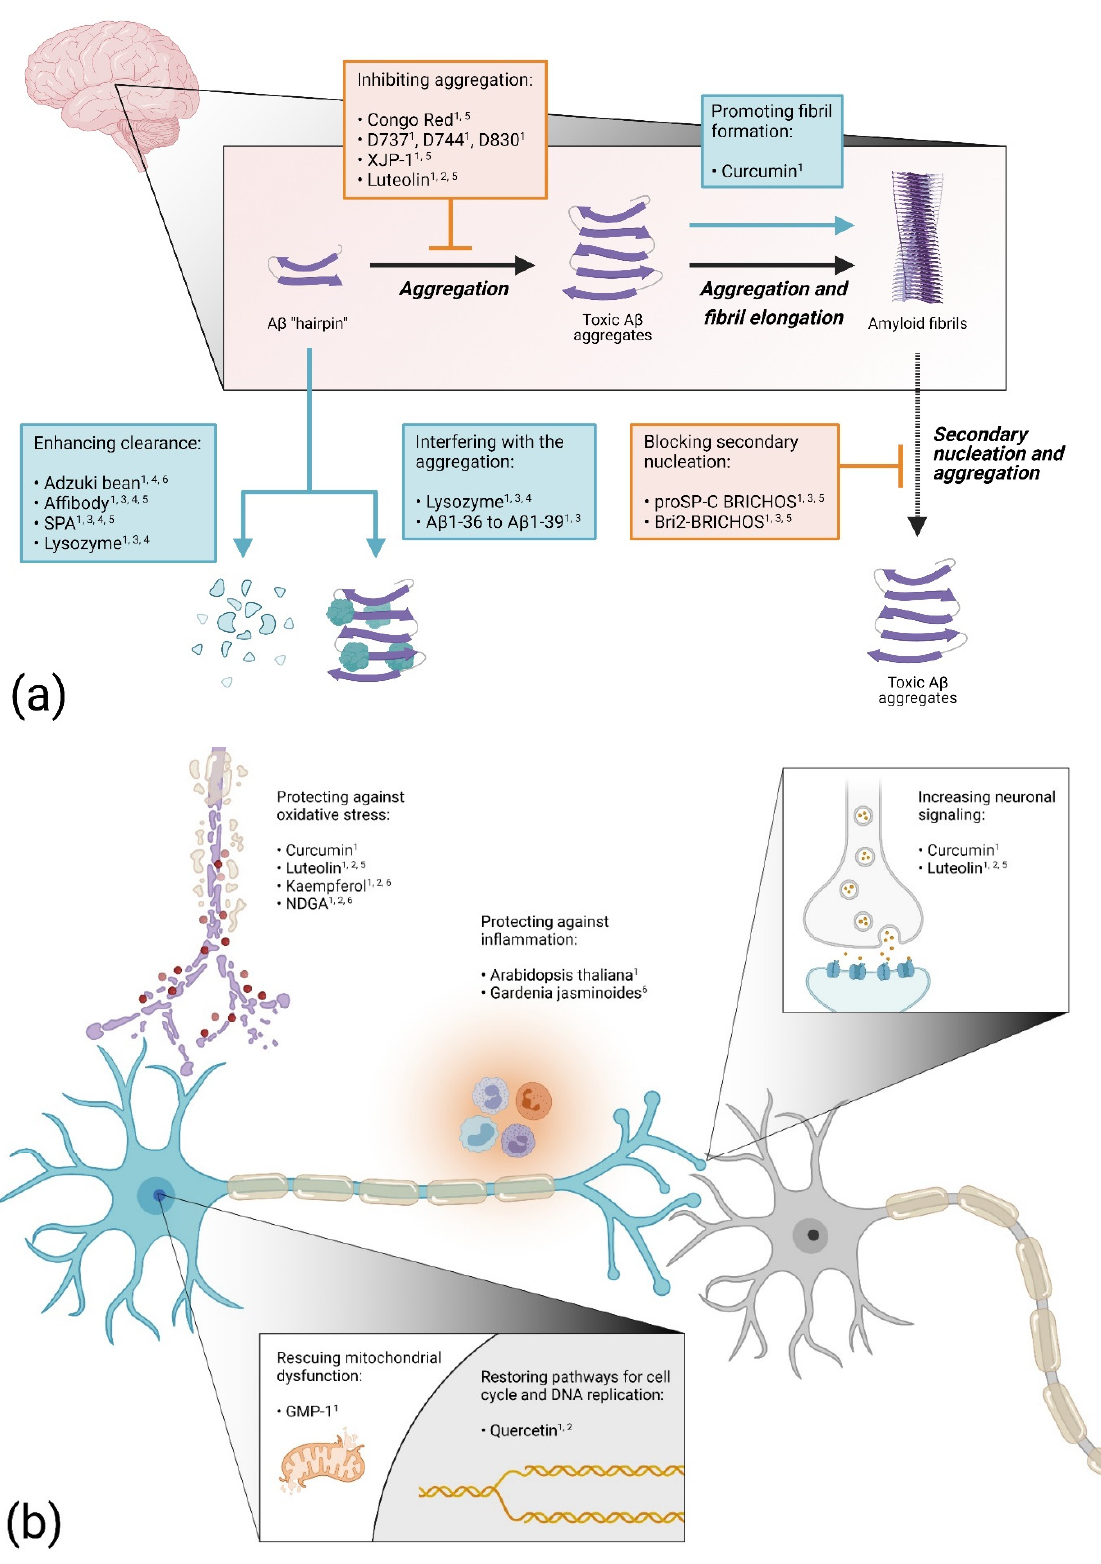
Figure 3. Overview of suggested anti-A β proteotoxicity mechanisms for different drugs examined in Drosophila : ( a ) drugs acting on the aggregation process; ( b ) drugs acting on cellular functions. Elevated numbers indicate confirmed protected effect in Alzheimer’s disease (AD) flies: 1 Improved viability; 2 Prevented adverse cellular impact; 3 Blocked cell death; 4 Reduced protein levels; 5 Reduced protein deposits; 6 Improved cognition. The figure was generated using BioRender.